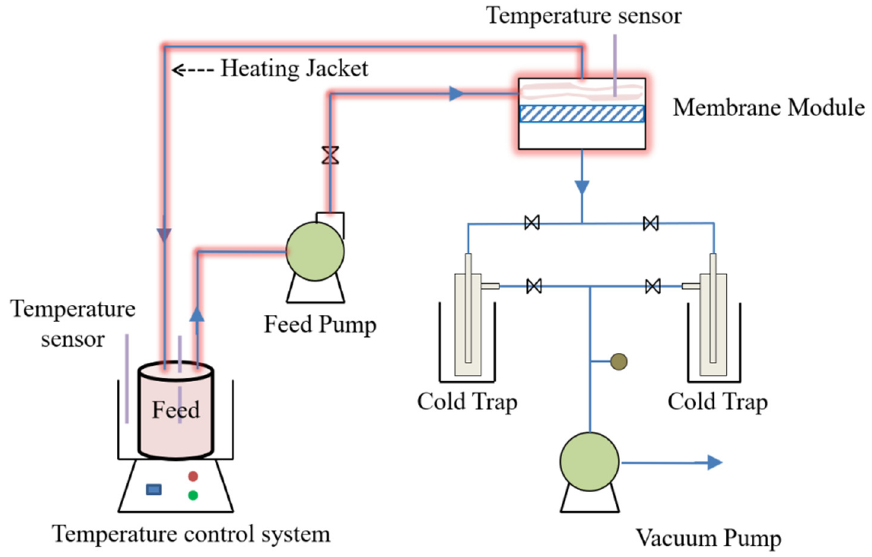
Scheme 1. Illustration of the pervaporation experiment process.